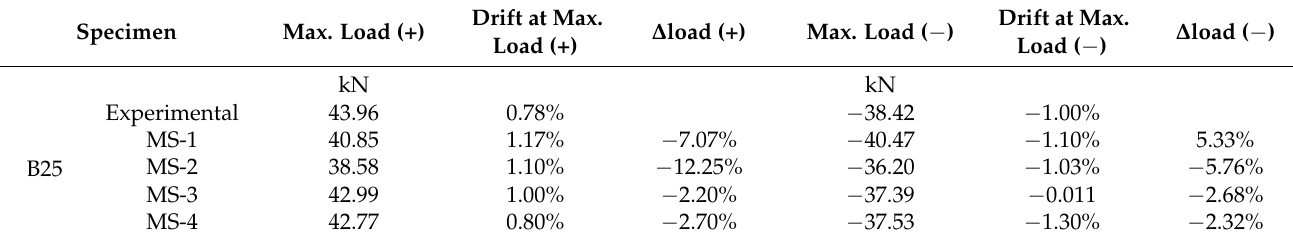
Table 8. Main results of corroded specimens B25, experimental vs. numerical.